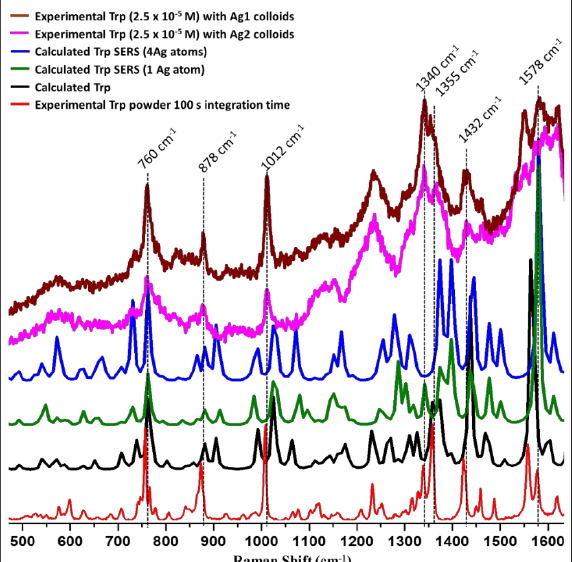
Figure 5. The comparison of theoretical and experimentally observed spectra for L-tryptophan.